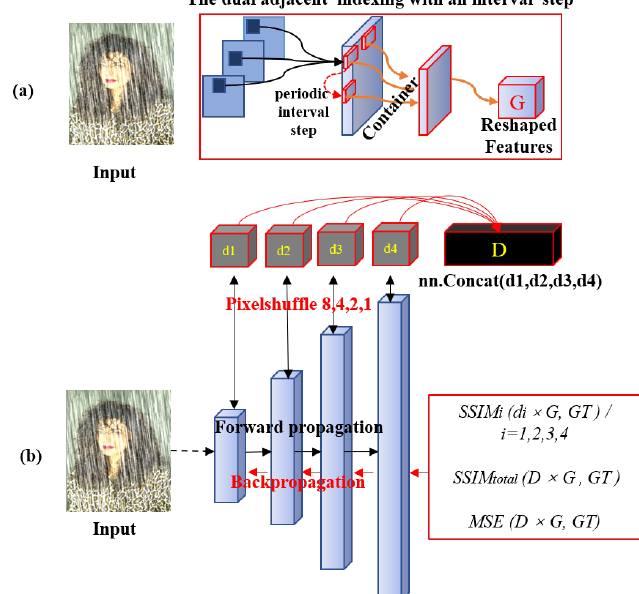
Figure 2. The formalisation of the proposed model-free algorithm. ( a ) is the indexing operation utilising dual adjacent channels whose computation is shown in detail in Figure 4. “G” denotes the reshaped features from the ground truth. ( b ) is the training feedback mechanism, which calculates the loss based on each deraining layer and the reshaped feature gained from ( a ). GT is the clear image which corresponds to the Input . “D” represents the features based on the concatenation of deraining features, namely “d1, d2, d3, and d4”. “nn.Concated()” is the common operation of PyTorch. SSIM i and SSIM total are the loss computations based on the criterion of the structural similarity index measure ( SSIM ), and MSE is the global loss computations based on the criterion of mean square error ( MSE